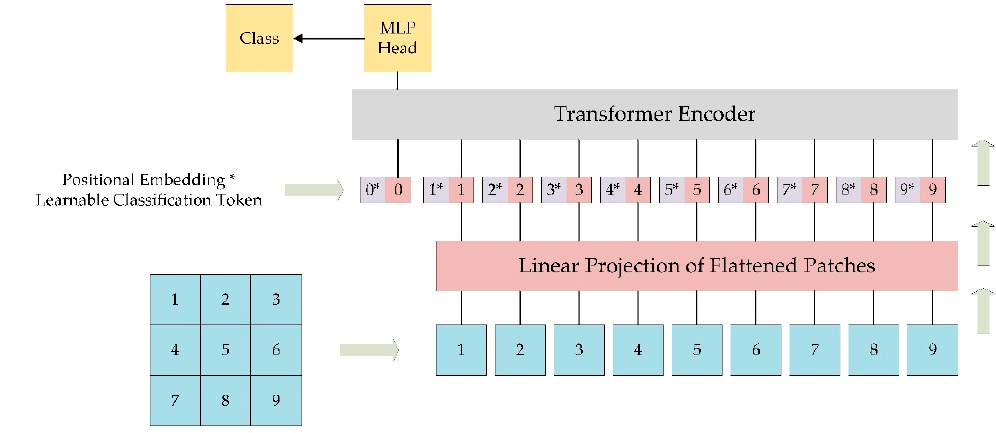
Figure 1. The overview of ViT.